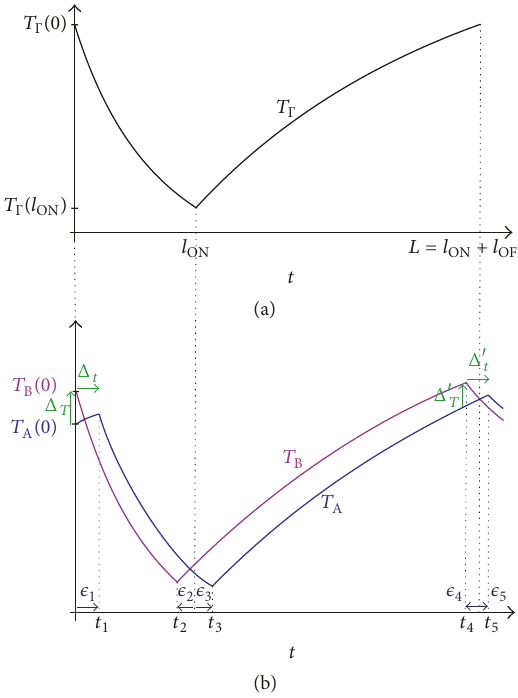
Figure 4: Linearisation about the single group solution. (a) Single group solution 𝑇 Γ (𝑡) . (b) Temperature cycling of groups A and B close to the single group